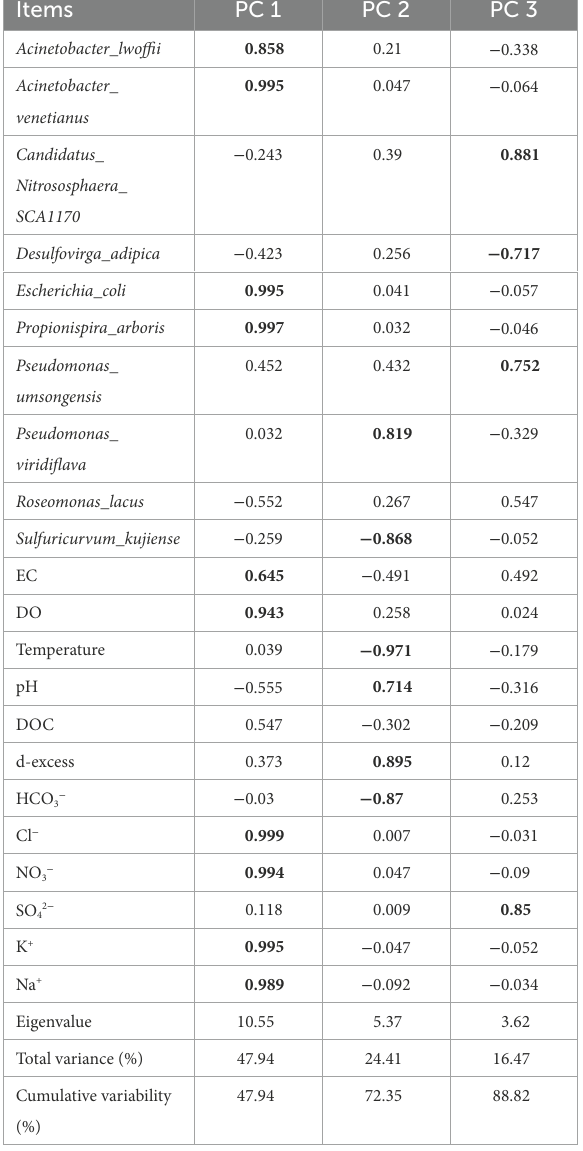
TABLE 3 The main component load of bacterial species and their water physics and chemical parameters.